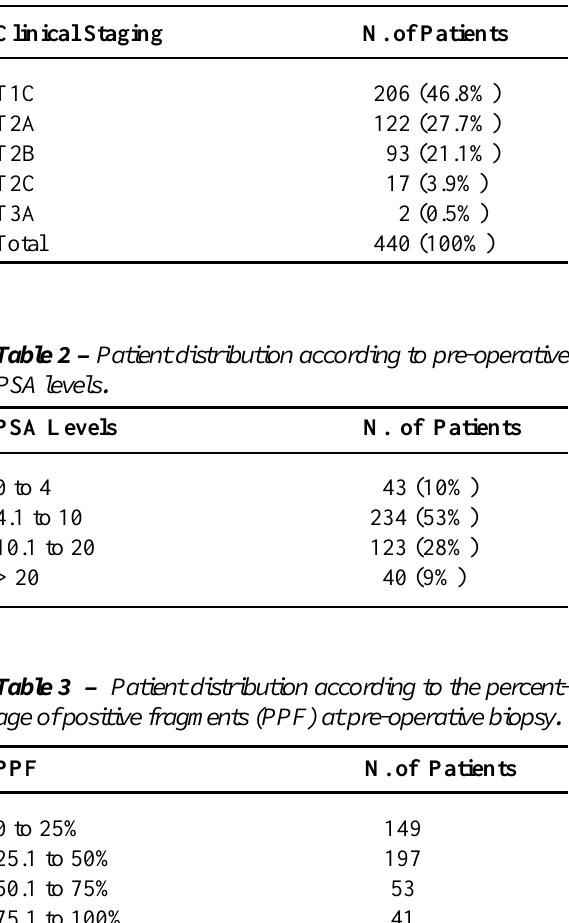
Table 1 – Patient distribution according to clinical stag- ing (AJCC, 1992).